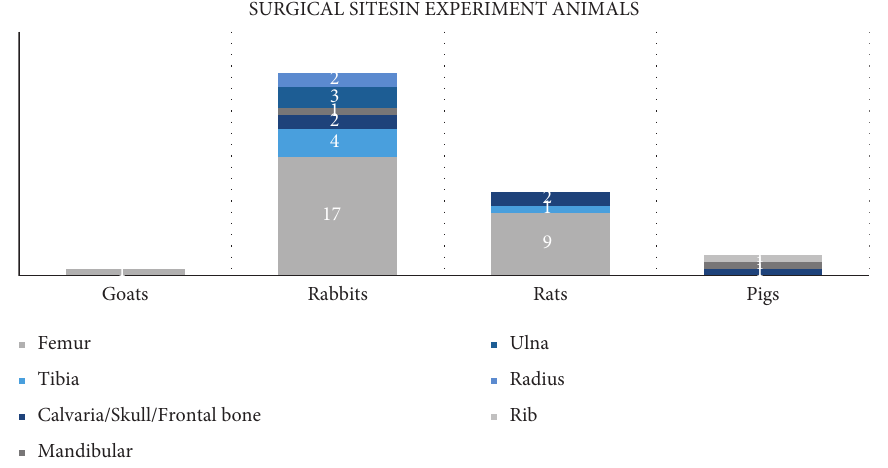
Figure 3: Animal models and surgical sites in included